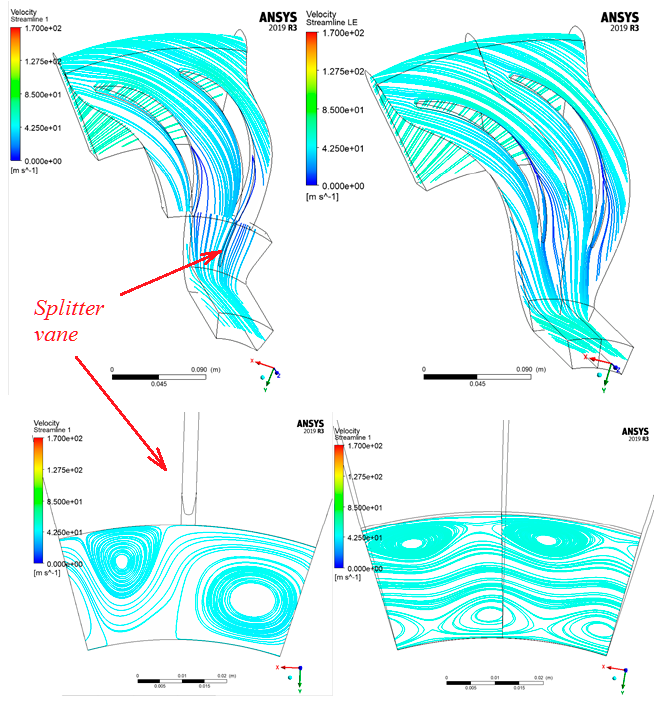
Figure 8. Flow structure of the RCh variants made with splitter vanes ( left ) and without splitter vanes ( right ). Velocity legend: from 0 to 170 m/s. Energies 2020 , 13 , x FOR PEER REVIEW